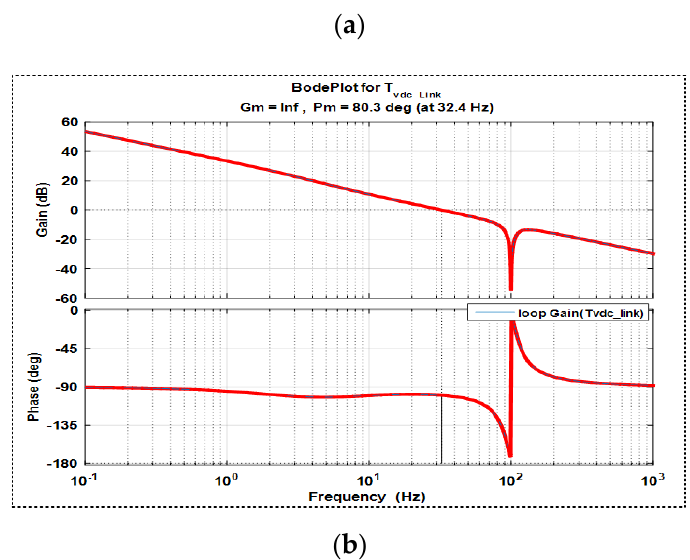
Figure 9. Bode plot: ( a ) T VDC ; (b) T VDC_link .